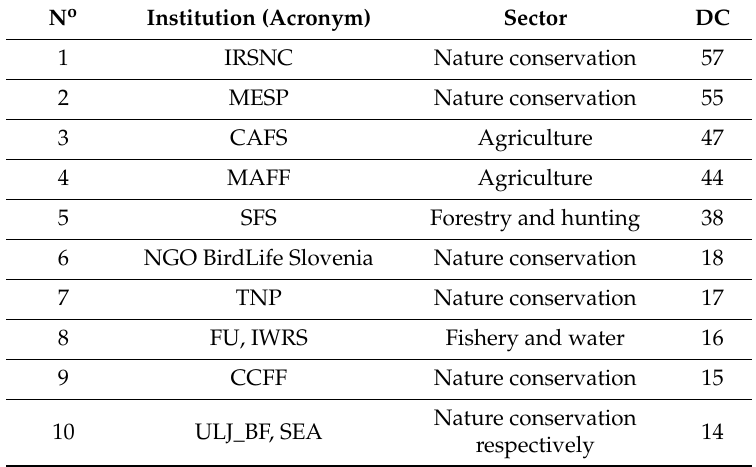
Table A1. Top 10 in the degree of centrality values (DC) for institutions in the undirected network of cooperation.